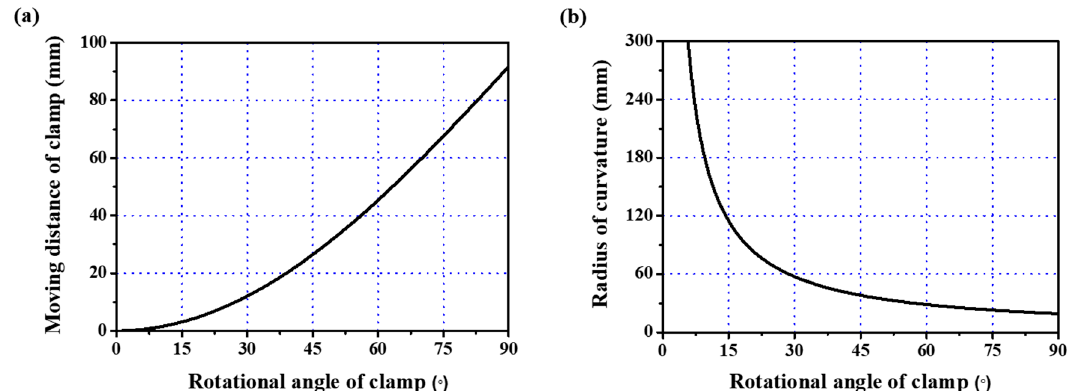
Figure 7. Calculation results of parameters to obtain the desired radius of curvature of the bent specimen: ( a ) relationship between the rotational angle and moving distance of Clamp 2; ( b ) relationship between the rotational angle and radius of curvature.